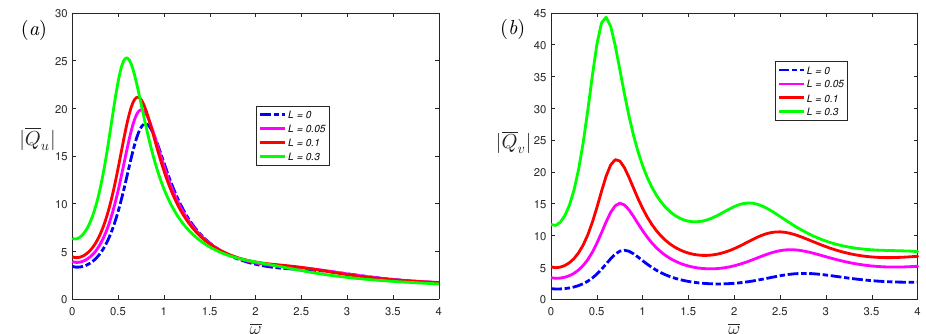
Figure 9. The dimensionless mean volumetric flow rate, ( a ) spanwise; ( b ) streamwise, of fractional Maxwell model with the dimensionless frequency ω for different dimensionless parameters L at α = 0.8, β = 1, K = 20, De = 5, Ha = 0.3.